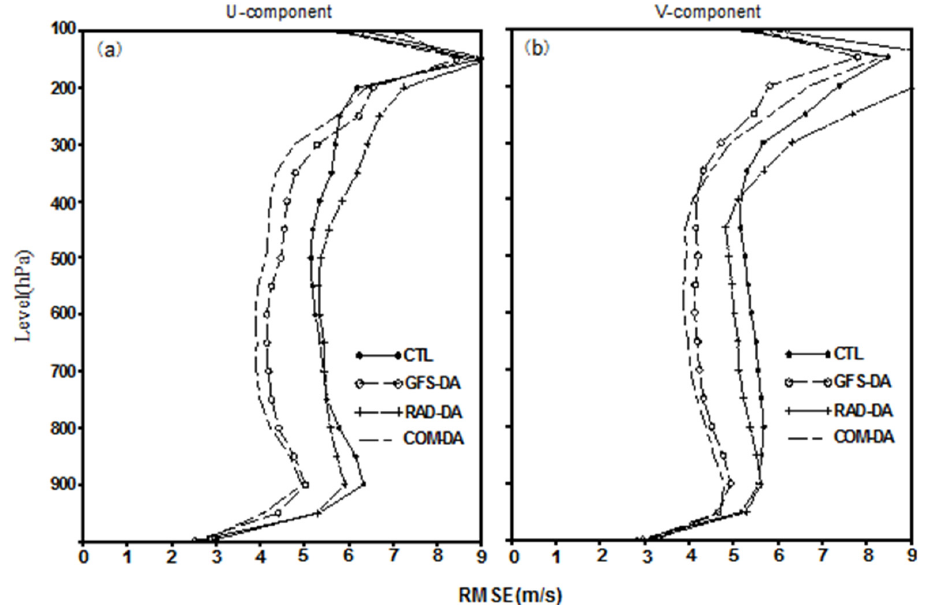
Figure 8. Vertical profile of 5-day mean RMSEs of large-scale ( a ) u and ( b ) v components for each experiment against the corresponding components in the GFS analysis, averaged over all grids in the inner domain. (unit: m s − 1 ).